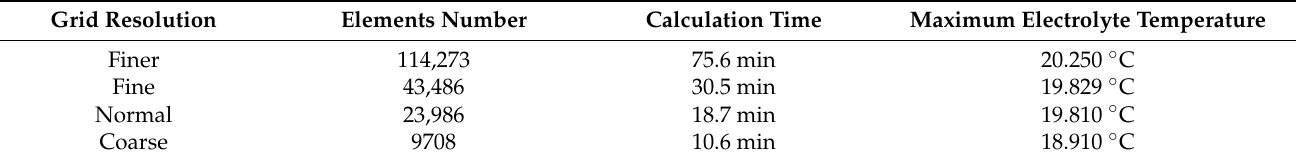
Table 1. This is a table. Tables should be placed in the main text near to the first time they are